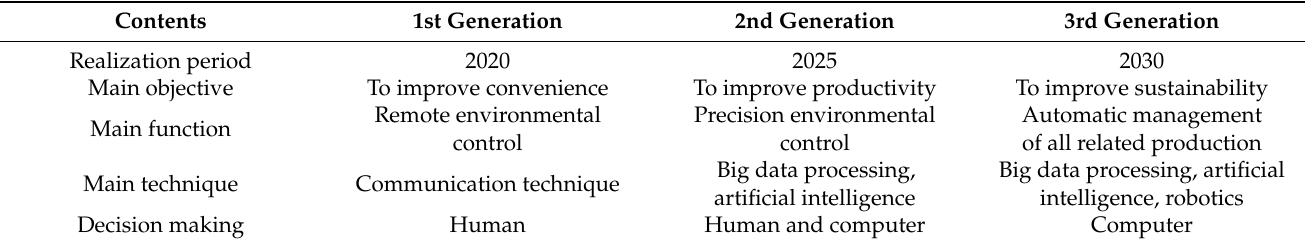
Table 1. Development plan for smart farms in South Korea